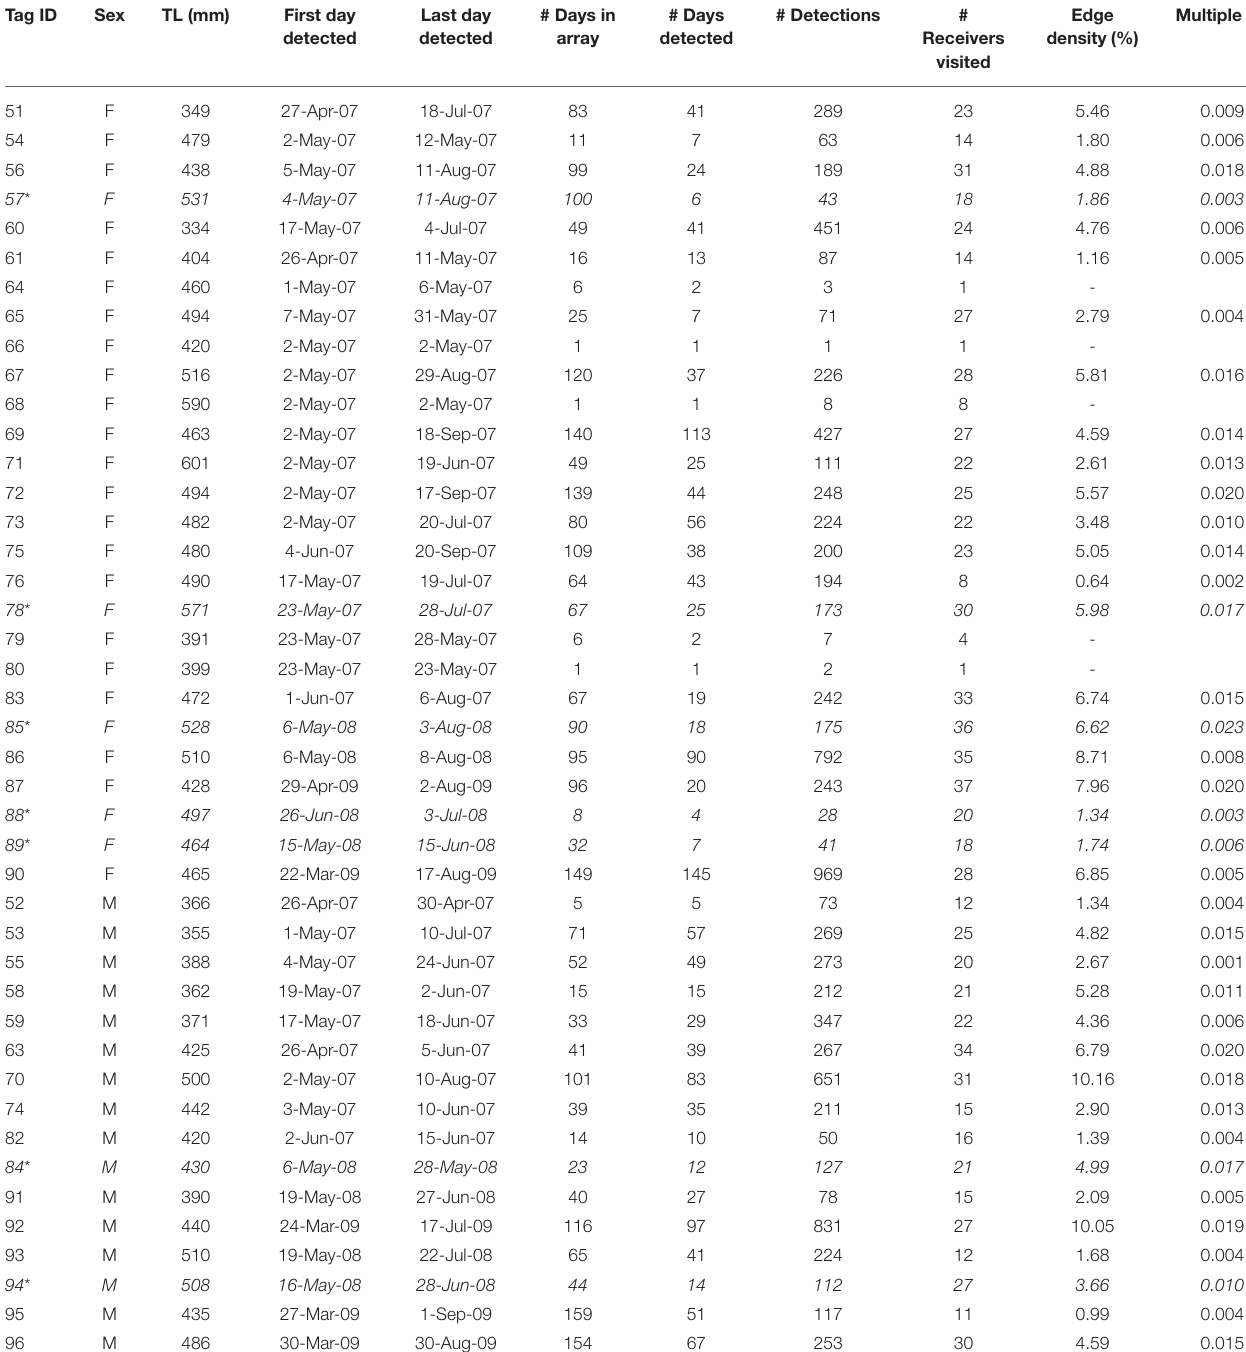
TABLE A2 | Summary of movement data and spatial network metrics for individual C. nebulosus tagged with acoustic telemetry transmitters ( n = 43) in Tampa